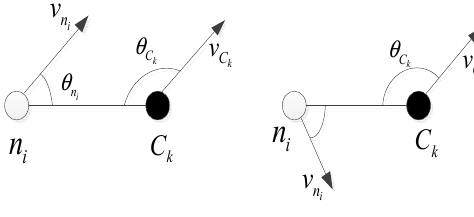
Figure 2. The mobility of the nodes.